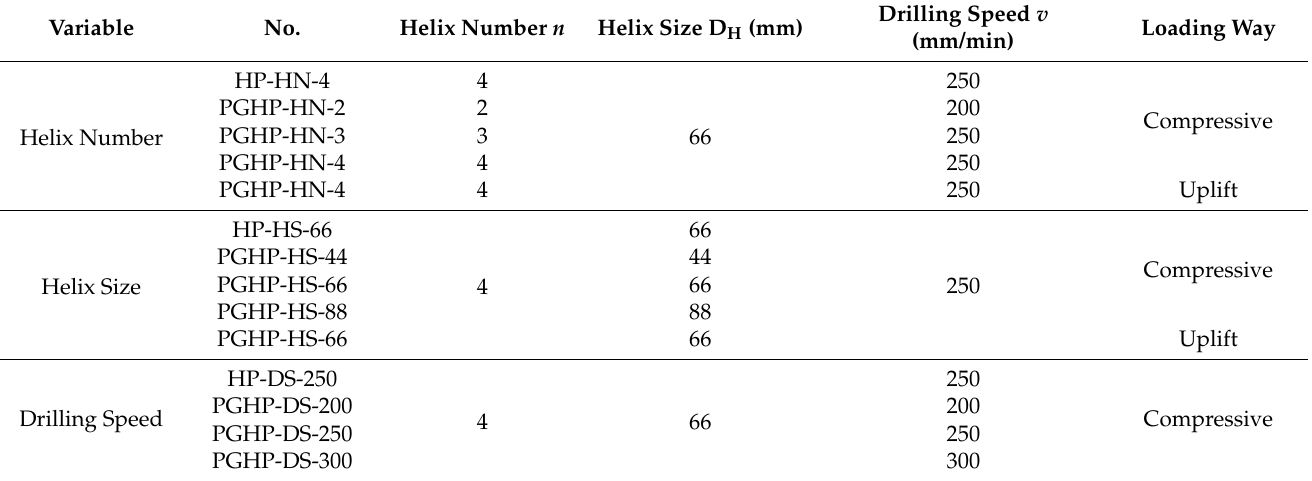
Table 1. Test plan and dimensions of small-scale pressure-grouted helical piles.